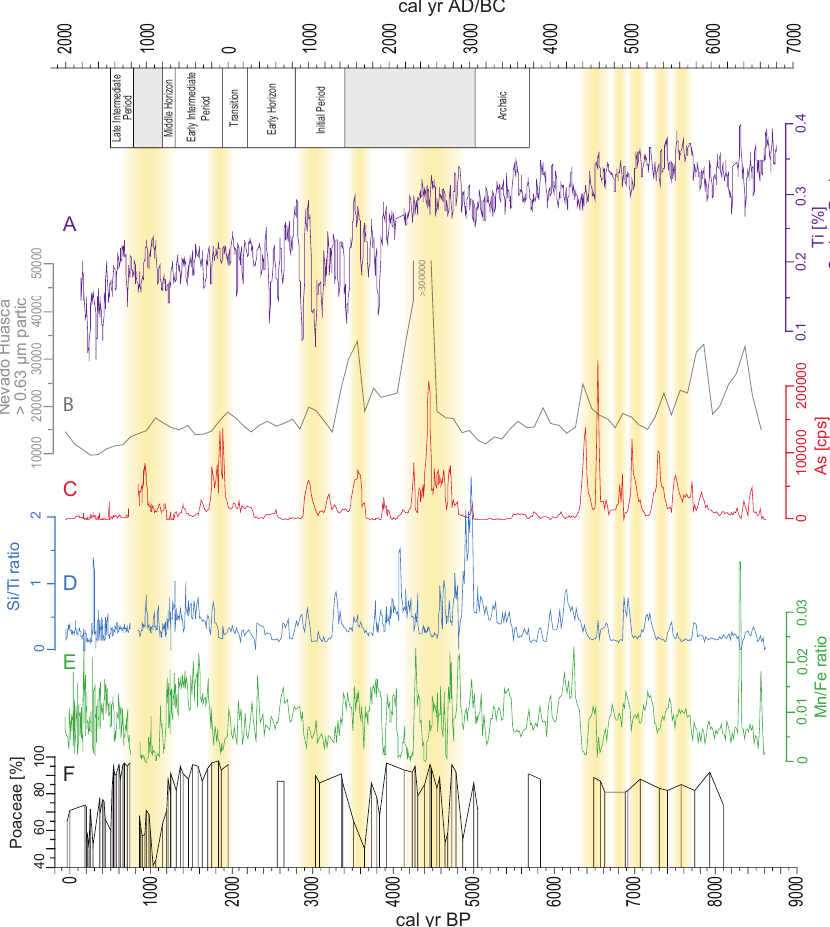
Figure 5. The archaeological chronology of the pre-Columbian cultures in the Palpa valleys (Unkel et al., 2012) compared with the bulk Ti content of Cariaco Basin sediments ( a ; Haug et al., 2001) and dust particle concentrations of Huascarán ice core ( b ; Thompson et al., 1995). (c) , (d) , (e) In situ geochemical parameters and the Poaceae pollen record (f) of the Cerro Llamoca